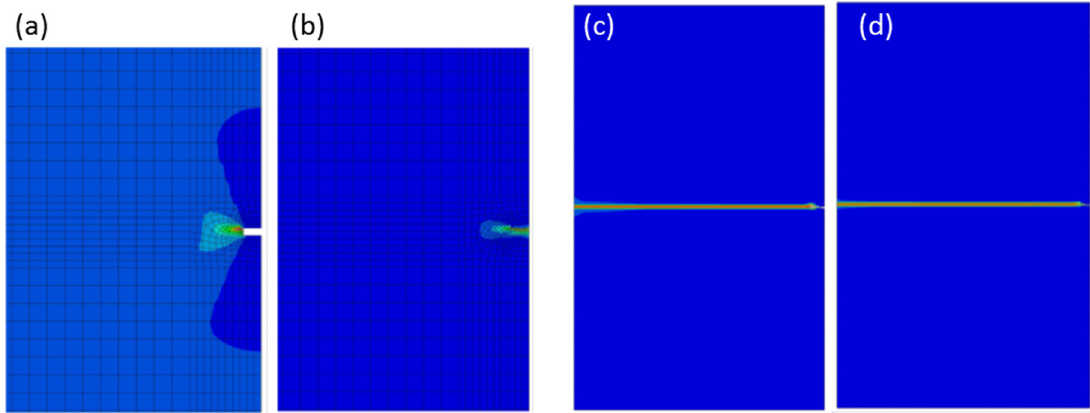
Figure 11. Distribution of the equivalent plastic strain in: the region around the aluminum crack visualized in Figure 8 at the maximum load, in the aluminum foil ( a ) and in the polyethylene film ( b ); in the whole specimen at the maximum elongation, in the aluminum foil ( c ) and in the polyethylene film ( d